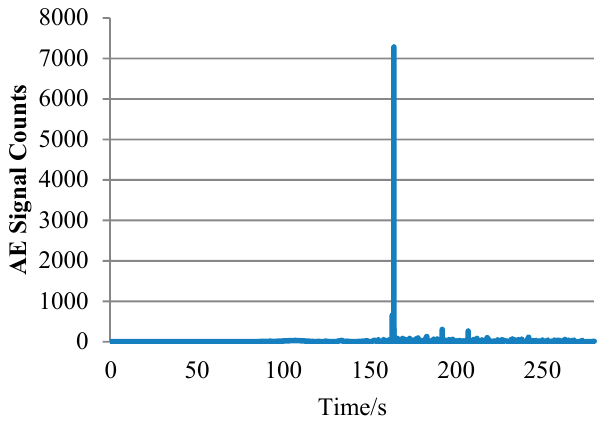
Figure 2. AE (Acoustic Emission) signal of the tensile failure in coal.